Question: In one sentence, what is this figure communicating?
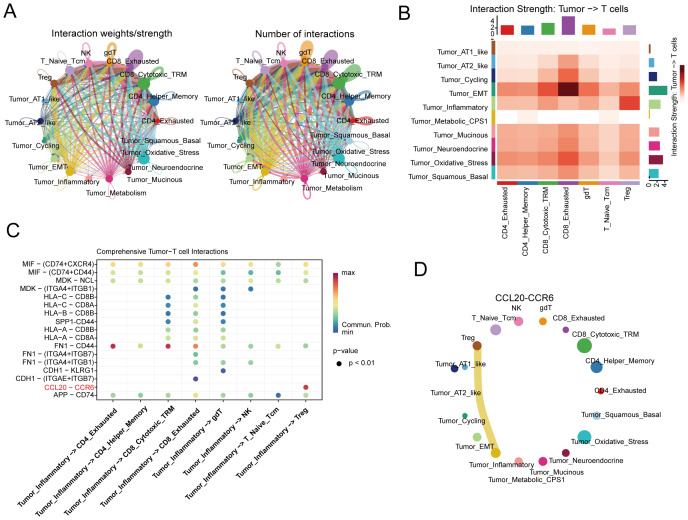
Answer: Cell-cell communication landscape between tumor subclusters and T cell subsets via cell chat analysis. (A) Cell communication network plots illustrating the overall interaction strength (left) and the number of interactions (right) between tumor subclusters and T cell subsets. Thicker and darker lines represent stronger communication. (B) Heatmap of interaction strength between different tumor subclusters as signal senders (Source) and T cell subsets as receivers (Target). Deeper red indicates stronger interaction, highlighting the potent signaling from the inflammatory tumor subpopulation (Tumor_Inflammatory) to Tregs. (C) Bubble plot of significant ligand-receptor pairs. This plot shows the molecular pairs significantly enriched in signals sent from the “Tumor_Inflammatory” subpopulation to various T cell subsets. Dot size represents the significance of the P-value, and color indicates the communication probability. The CCL20-CCR6 interaction targeting Tregs is highlighted in red. (D) Circos plot (circle plot) specifically depicting the CCL20-CCR6 signaling pathway. The arrow direction indicates signal flow, and the line width represents signal strength. The results clearly show that CCL20 signals are predominantly emitted by inflammatory and EMT-type tumor cells and specifically target Tregs.